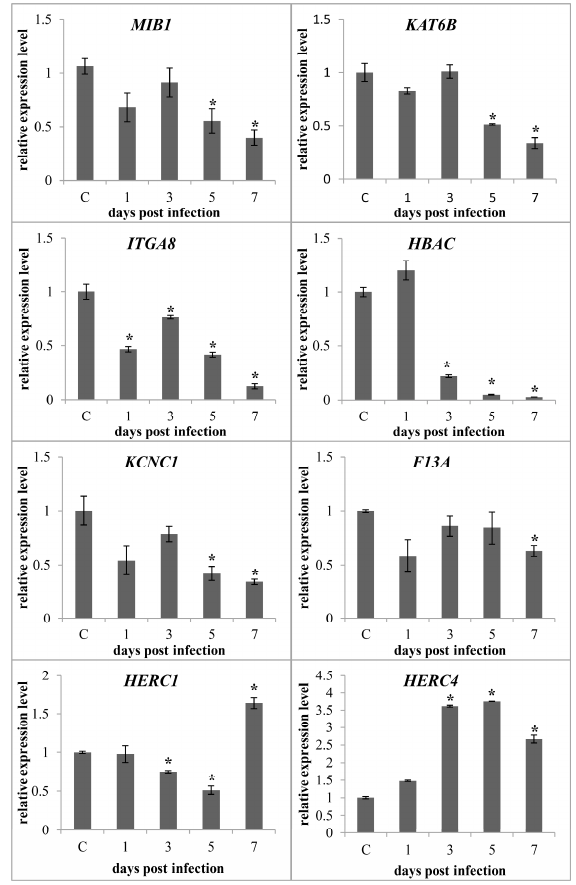
Figure 5. Expression patterns of eight selected parental genes. Eight parental genes were selected for qPCR to validate the expression level at the five time points. The relative expression level of parental genes at different time points were calculated as the ratio of the gene expression level relative to that at 0 dpi (controls). All data are represented as means ± standard deviation of three replicates. Significant differences ( p < 0.05) between infected and control samples (0 days post-infection) are indicated with an asterisk (*). Table 3. Parental genes corresponding to differentially expressed